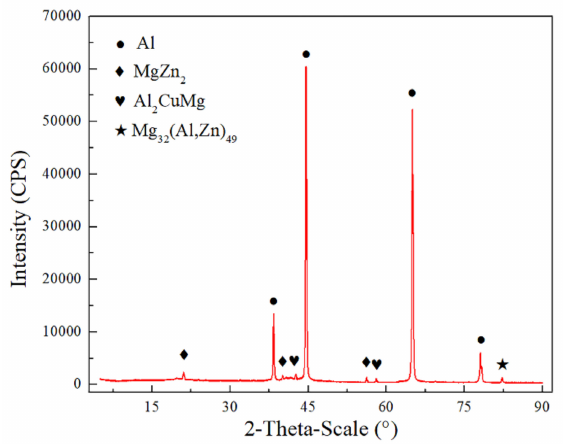
Figure 5. X-ray di ff raction pattern of